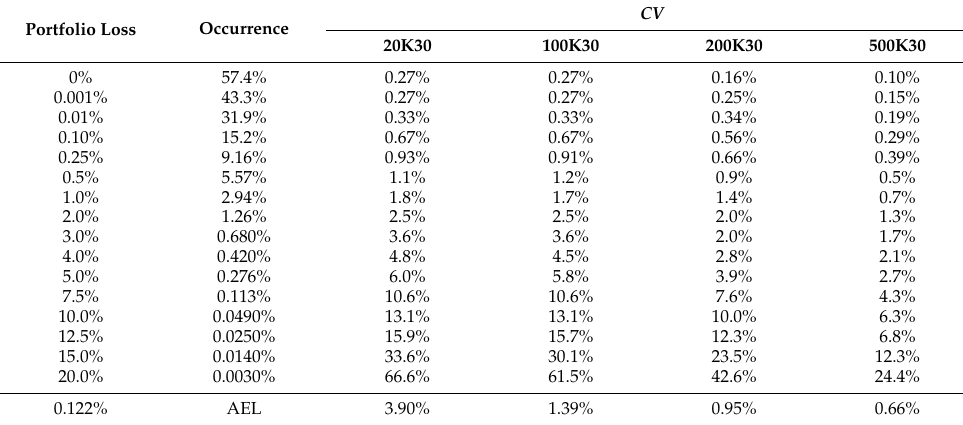
Table 12. Comparisons of the loss values with the CV for the percentage loss for exceeding the loss value for the Model Portfolio for different Bootstrap approaches depending on the original loss Monte Carlo simulation total. 500K30 means 500 K. The portfolio value is $2.3 Billion. The column Occurrence indicates the probability of the loss value is exceeded as determined from the 500K30 simulations results. The annual expected loss, AEL, of the 500K30 simulations is 0.122% and the CV of this loss for the different simulation numbers are as indicated; The CV are so low because there are so many loss simulations below this loss